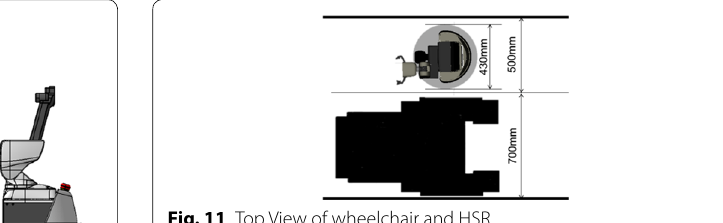
Fig. 11 Top View of wheelchair and HSR